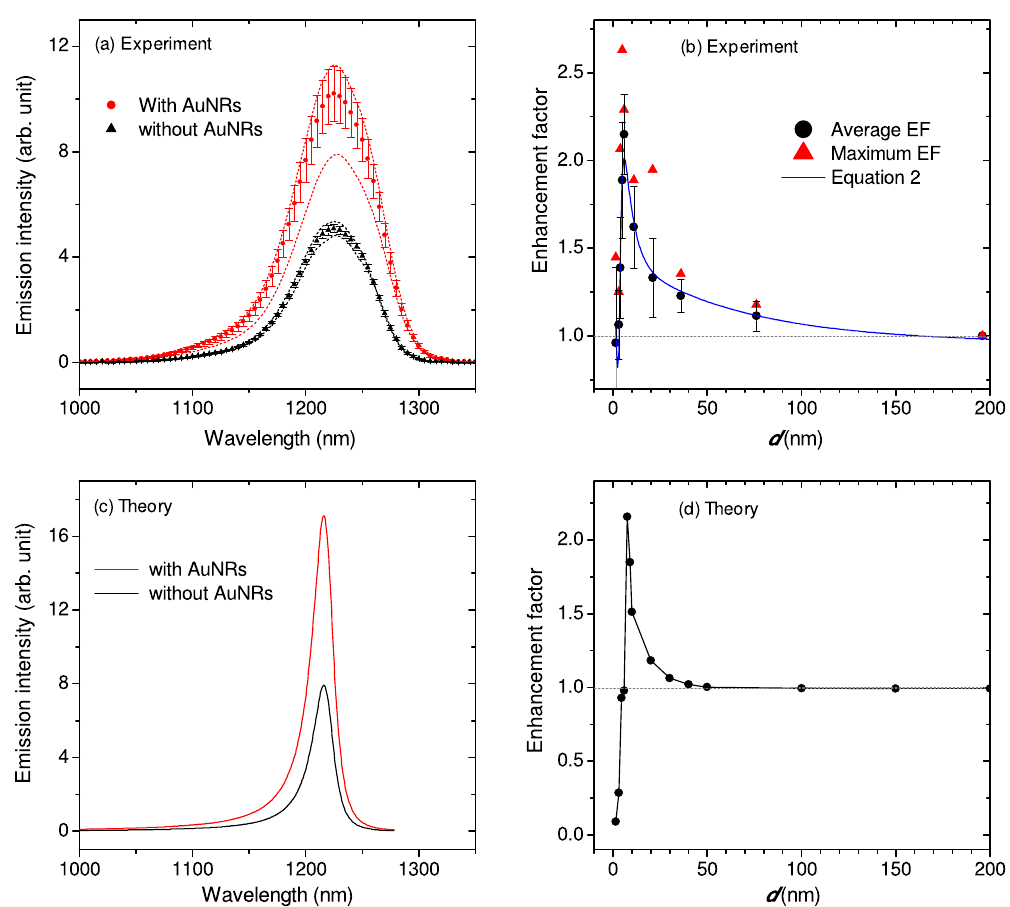
Figure 3. Emission enhancement and distance dependence. ( a ) Photoluminescence acquired from different locations where there are no AuNRs (black lines) and where there are AuNRs (red lines) for 6 nm GaAs thickness ( d ) as an example. ( b ) Integrated intensity ratio (enhancement factor) as a function of d . The error bars on the average data points (black circles) represent one standard deviation. The maximum enhancement factors (red triangles) represent the ratios of the integrated intensities of the highest intensity spectra obtained in the presence and absence of AuNRs for different GaAs thicknesses. The solid blue line is obtained by fitting equation (2) to the average data. ( c ) Calculated emission spectra of InAs QDs for d = 7.5 nm in the presence (red line) and absence (black line) of AuNRs. ( d ) Calculated enhancement factor (ratio of emission intensities) plotted as a function of d